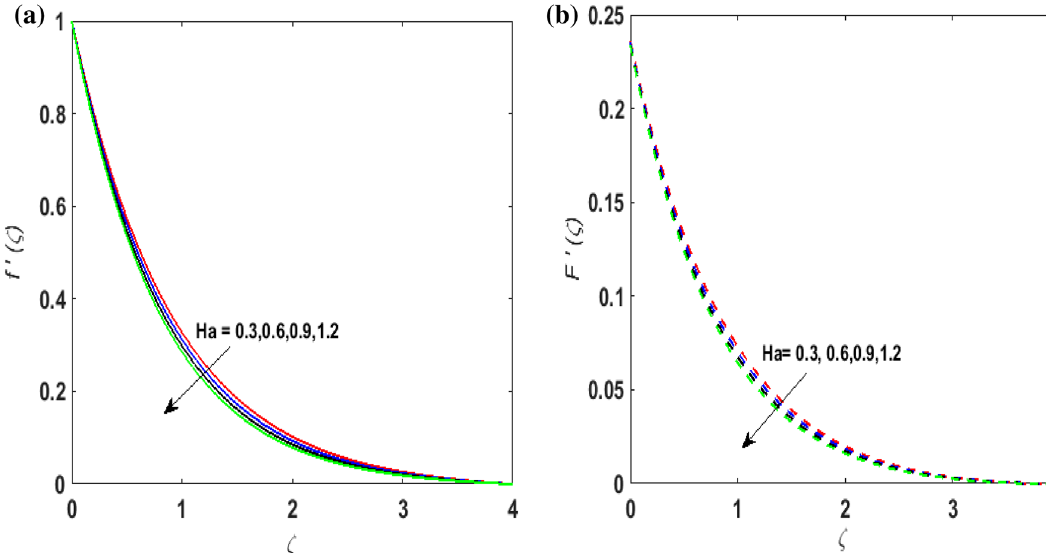
Figure 4. ( a ) f ′ (ζ) for various Ha . ( b ) F ′ (ζ) for various Ha .